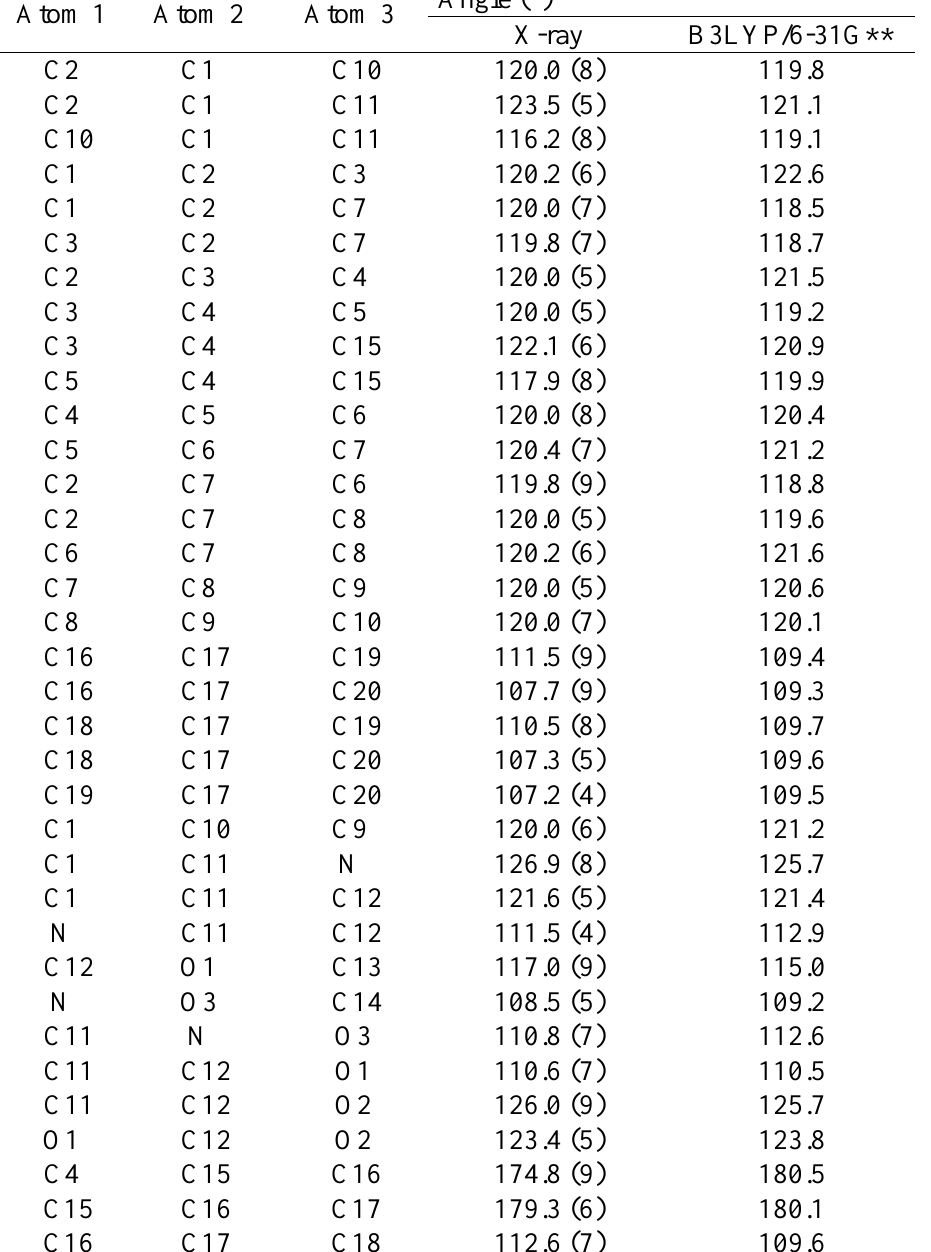
Table 2. Selected bond angles (°) by X-ray and theoretical